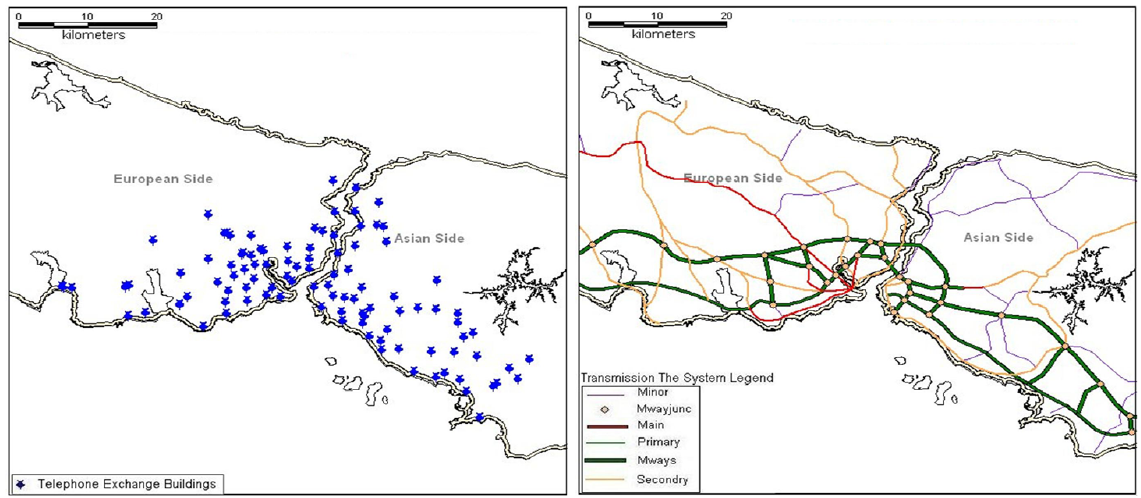
Figure 15. Telecommunication buildings (left) and transportation network (right) with a uniform, 600m-width buffer zone which corresponds to 2 Fig. 15. Telecommunication buildings (left) and transportation network (right). A uniform, 600m-width buffer zone which corresponds to the maximum inundation distance from the coastline (adopted from KOERI, 2002). 3 the maximum inundation distance from the coastline is also shown (modified after KOERI,